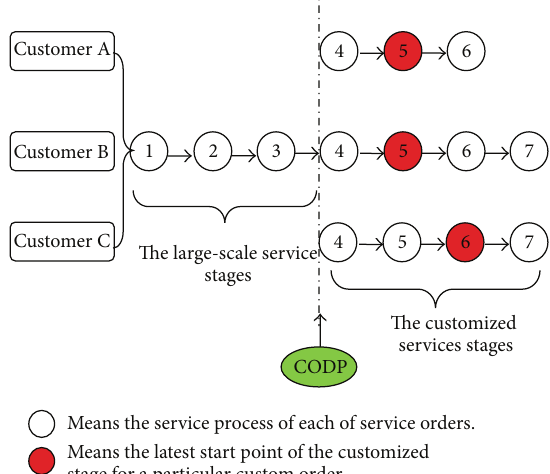
Figure 1: Schematic diagram of each order’s operation process requirement in numerical example.